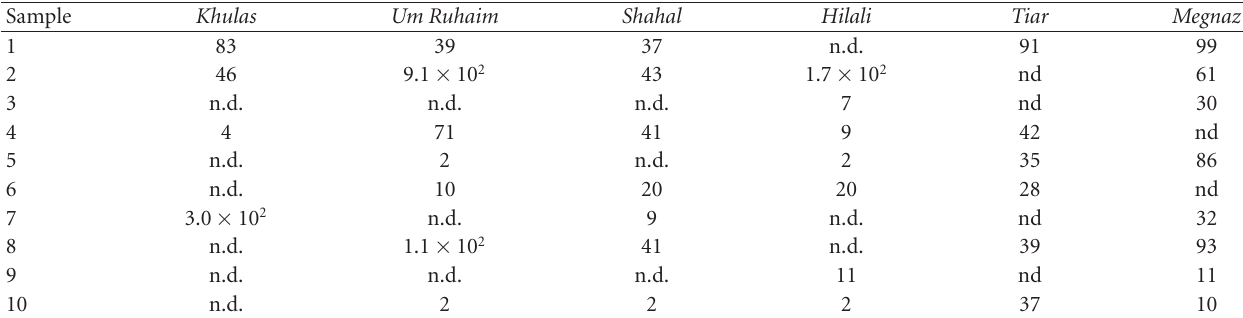
Table 4: Counts of coliforms (cfu/cm 2 ) contaminating rutab